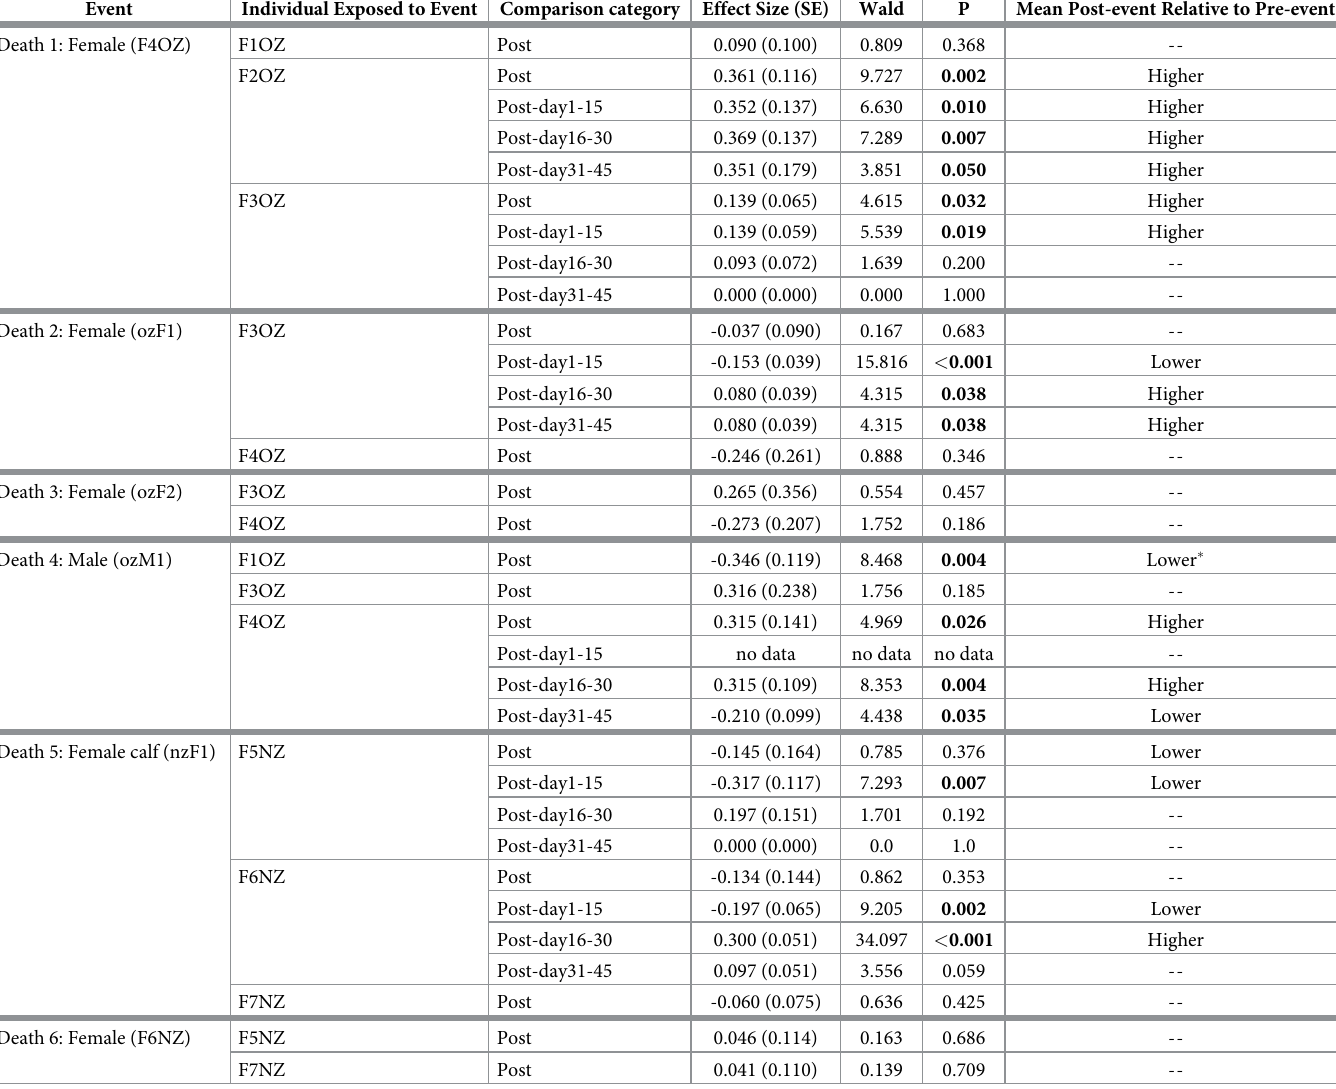
Table 5. Death to a herdmate as a predictor of adrenal GC activity. Fixed effects, effect size with standard error (SE), Wald statistic, and p-value from GLMMs, and whether the mean cortisol concentration post-event is higher or lower than pre-event. Degrees of freedom (df) was 1 in all pair-wise comparisons. Event Individual Exposed to Event Comparison category Effect Size